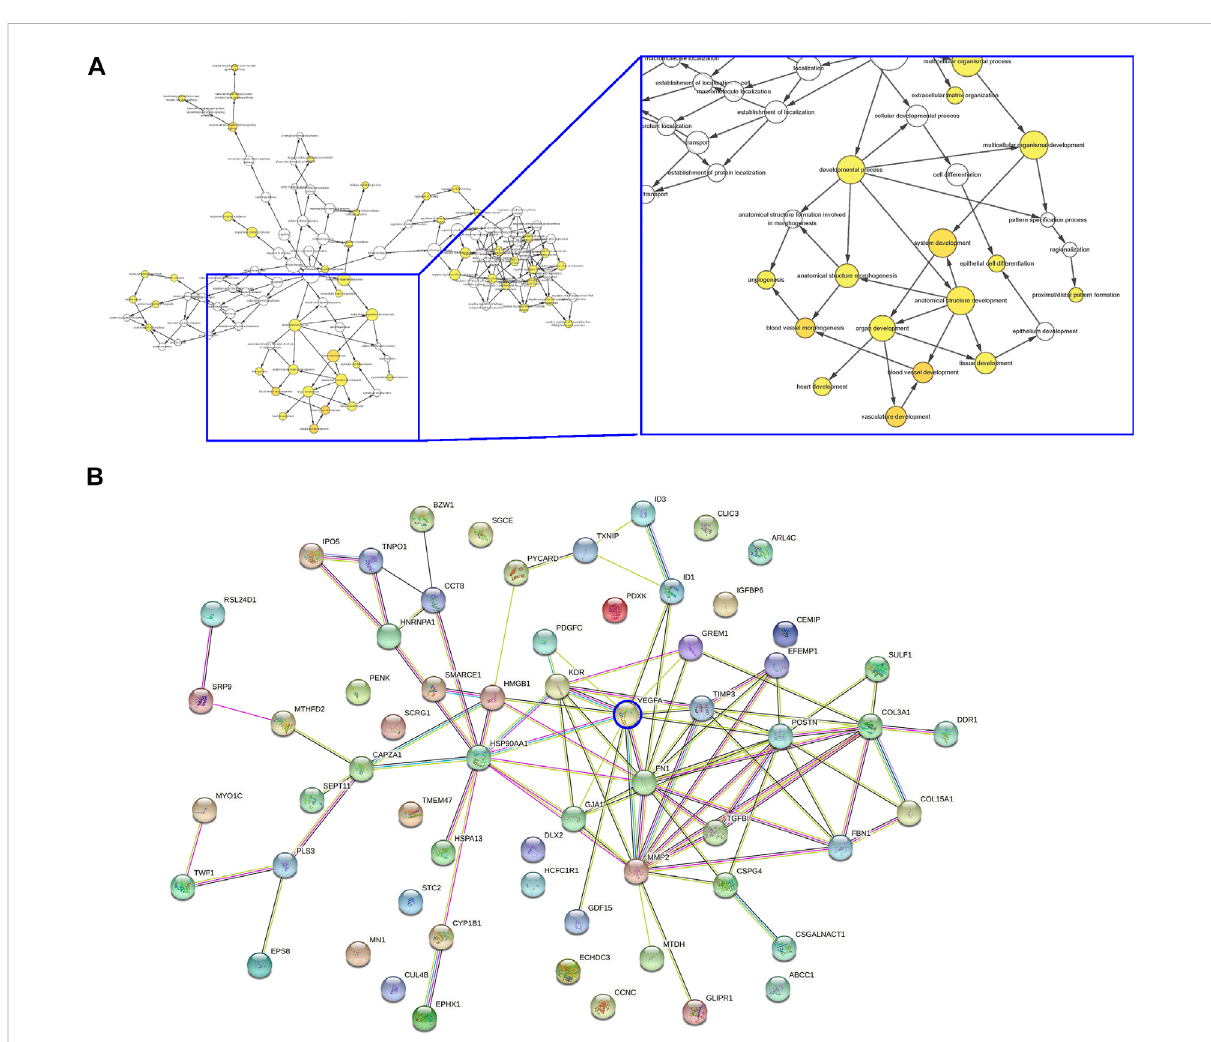
FIGURE 3 VEGF-A and angiogenesis -associated genes are the mainly affected ones in discs from LDD. (A – B) Differential genes in the analysis for GEO34095 were presented for pathway analysis by Cytoscope (A) and gene-gene relationship by String (B)